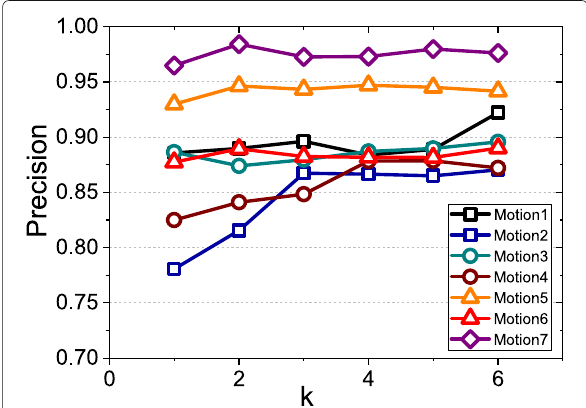
Fig. 6 The impact of k on the precision of PLF-RKDR algorithm on the real dataset